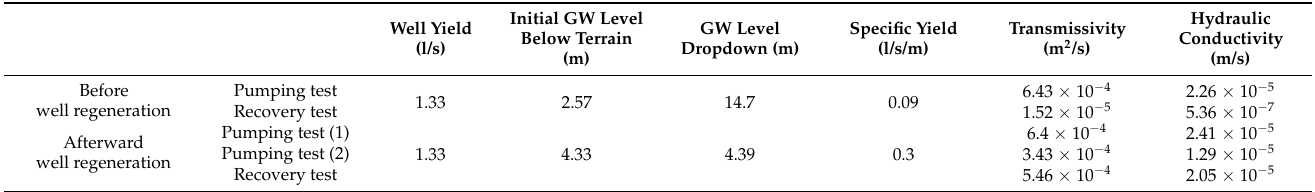
Table 2. Results of pumping and recovery tests for extraction well HJ-3 [47]. Well Yield